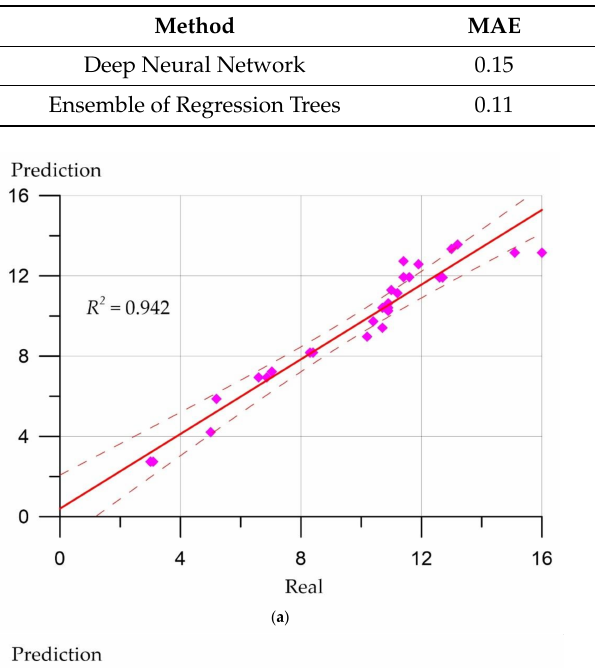
Table 8. Comparative characteristics of the work of the implemented methods on the test sample when determining the axial tensile strength.